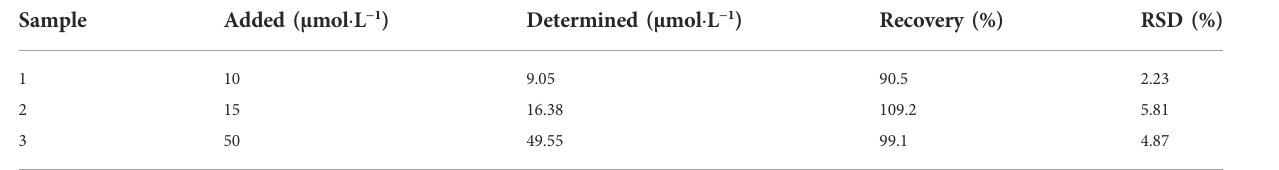
TABLE 2 The test of sample spike recovery (n =